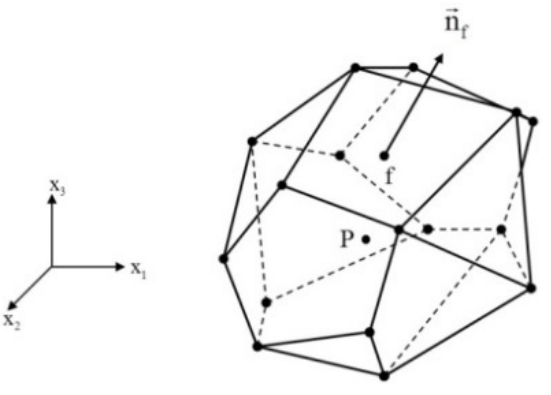
Figure 1. General view of a cell.